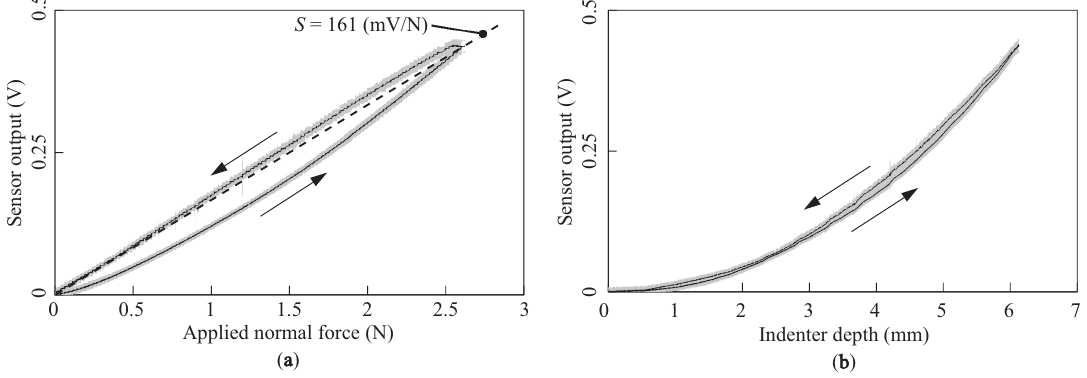
Figure 6. Sensor response curves with a contact speed V of 0.1 mm/s: ( a ) the sensor output versus the applied normal force; ( b ) the sensor output versus the indenter